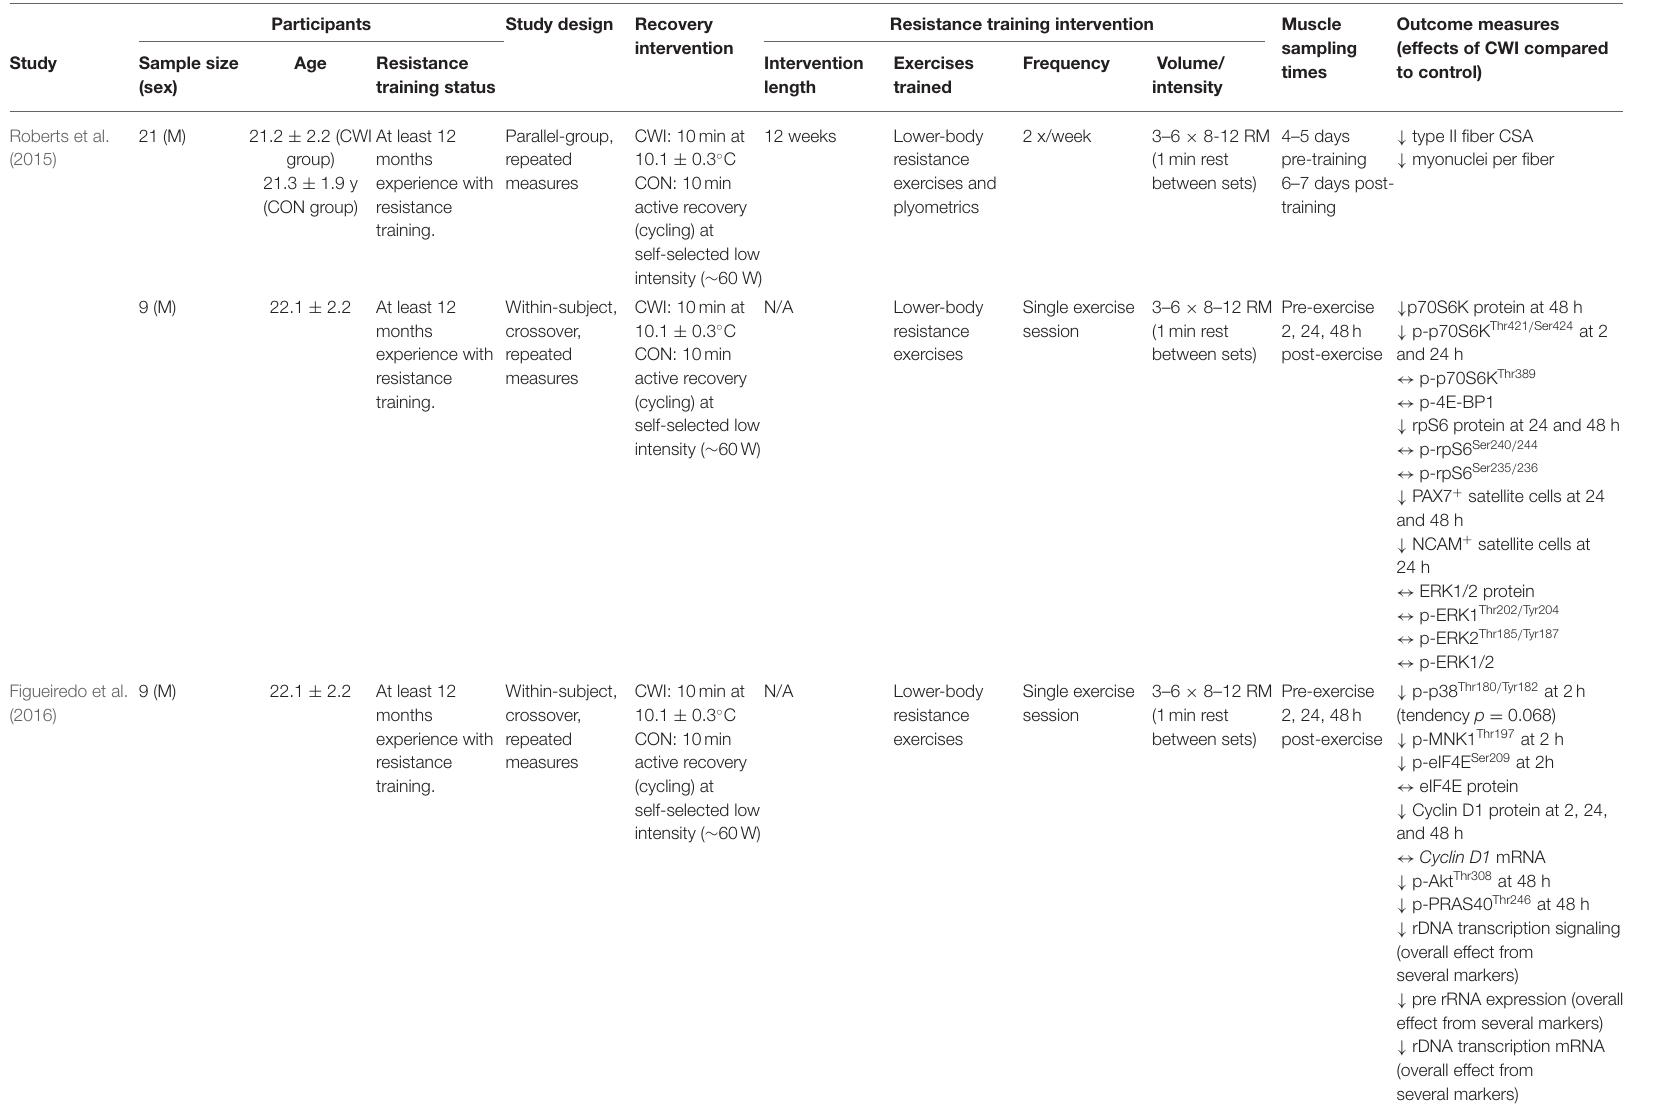
TABLE 2 | Summary of post-exercise cold-water immersion effects on molecular responses to resistance exercise in human skeletal